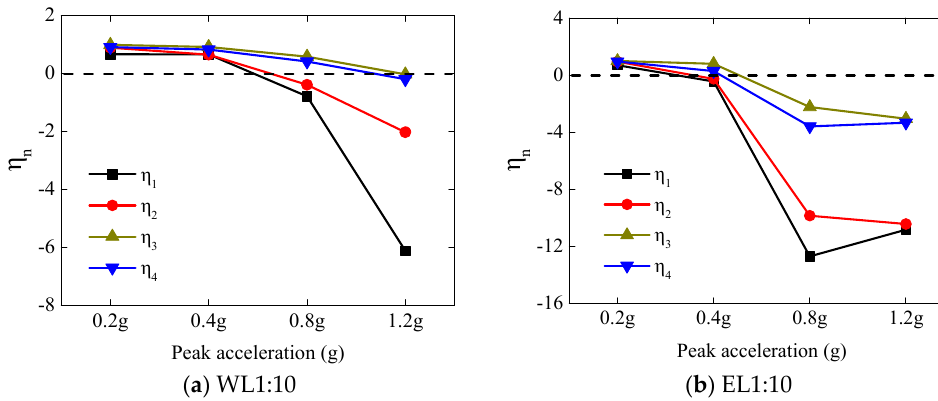
Figure 13. Muni method [16] for yield acceleration at a value of η n.